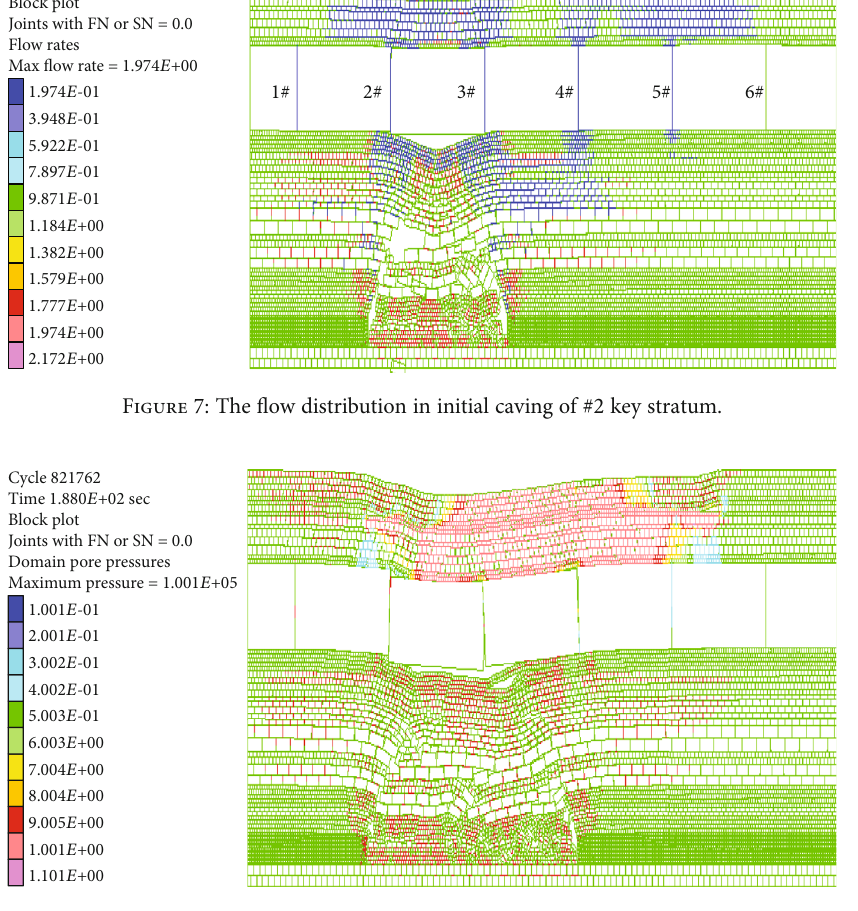
Figure 8: The pore pressure distribution in initial caving of #3 key